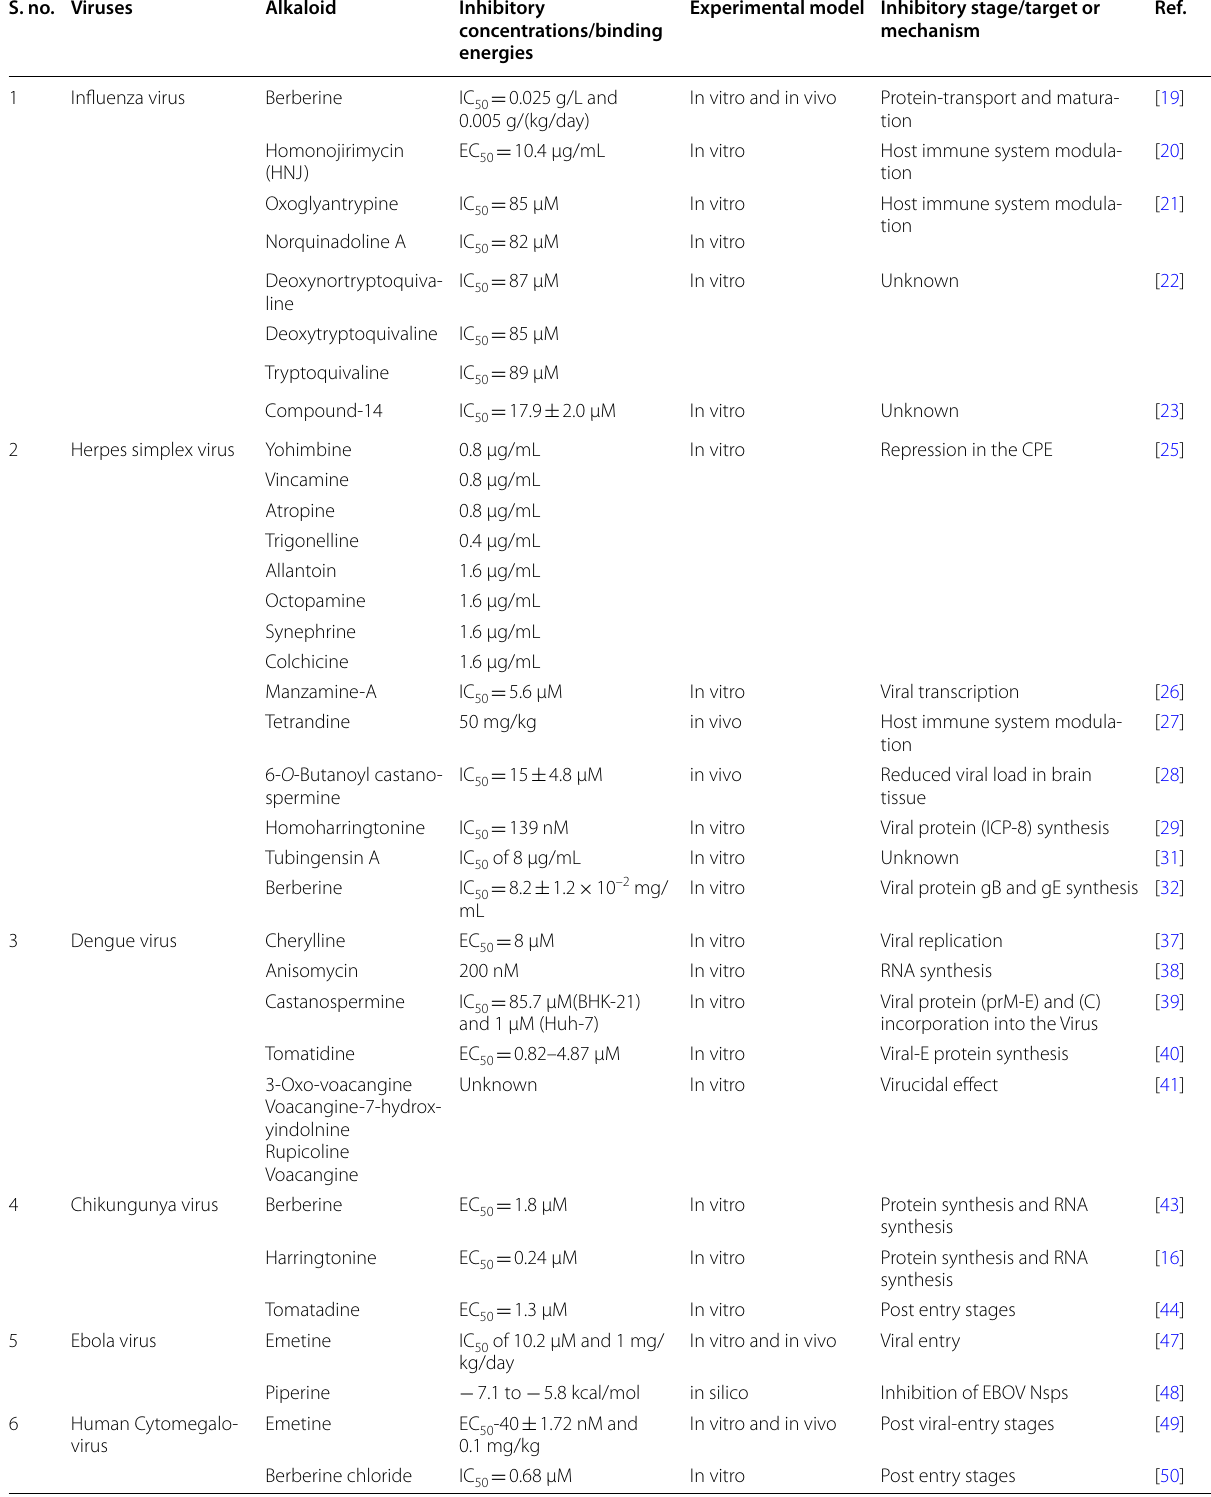
Table 1 Antiviral activities of the discussed alkaloids S. no. Viruses Alkaloid Inhibitory